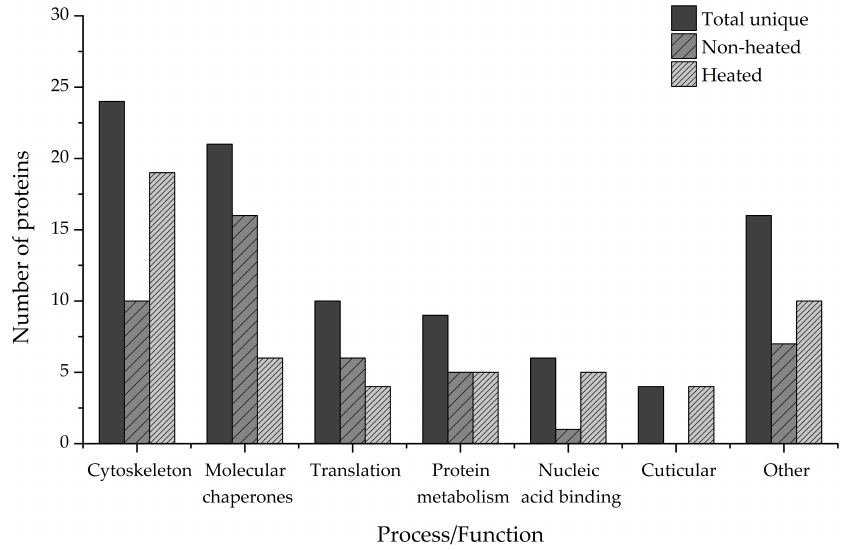
Figure 8. Biological processes and molecular functions of intrinsically disordered proteins and proteins containing long IDRs. The category Other encompasses processes and functions that make up less than 4% of total hits each. Total unique—all uniquely identified proteins; Non-heated—all proteins identified in the non-heated sample types; Heated—all proteins identified in the heated sample